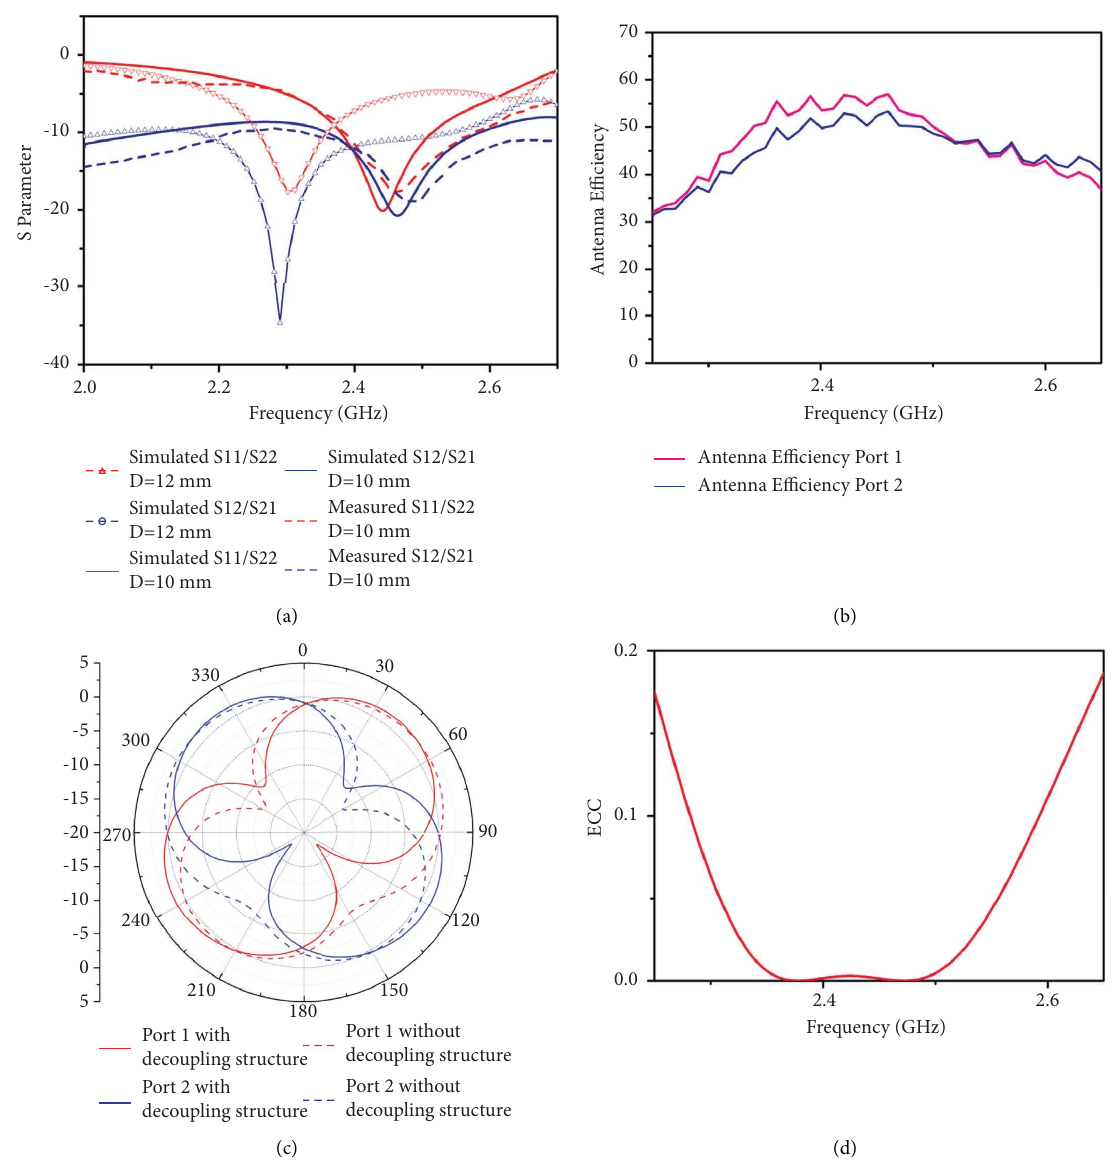
Figure 6: (a) S -parameters of the proposed frequency-reconfguration decoupling antenna with diferent D (simulated and measured). (b) Antenna efciency (measured). (c) 2D radiation gain (simulated). (d) ECC (simulated) at 2.44GHz for D � 10